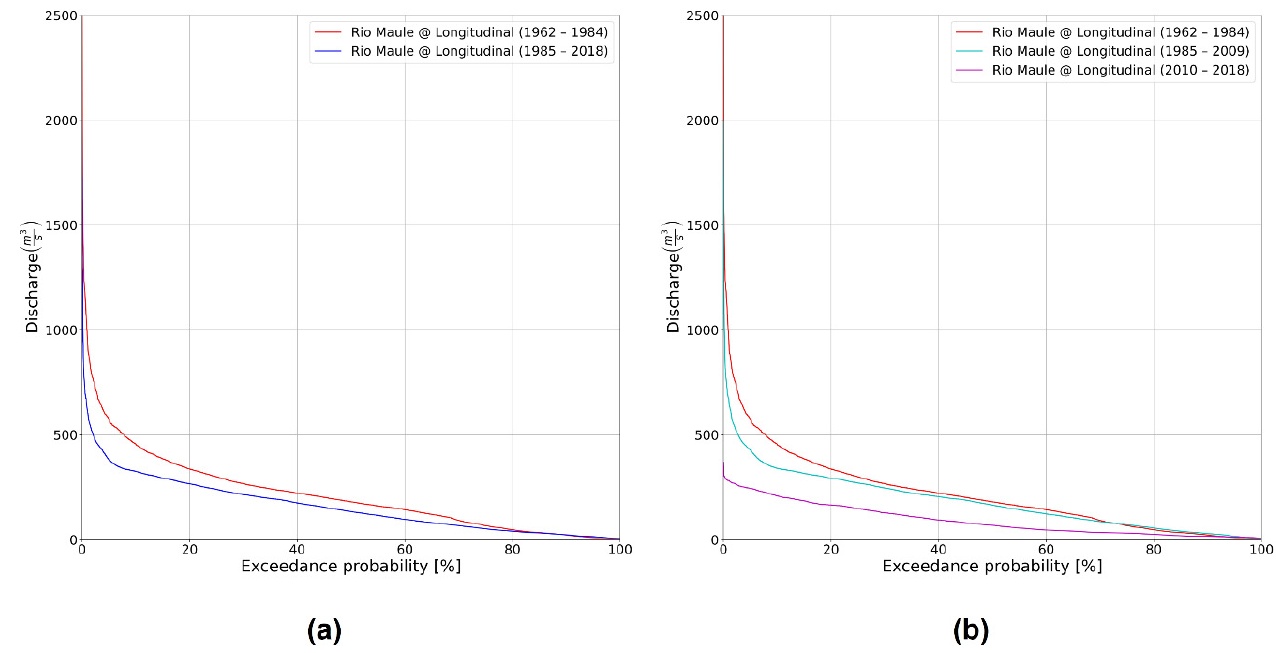
Figure 10. ( a ) Flow exceedance probability for both periods, ( b ) Flow exceedance probability, with separation of the regulation period before and after 2010 (i.e., documented beginning of the